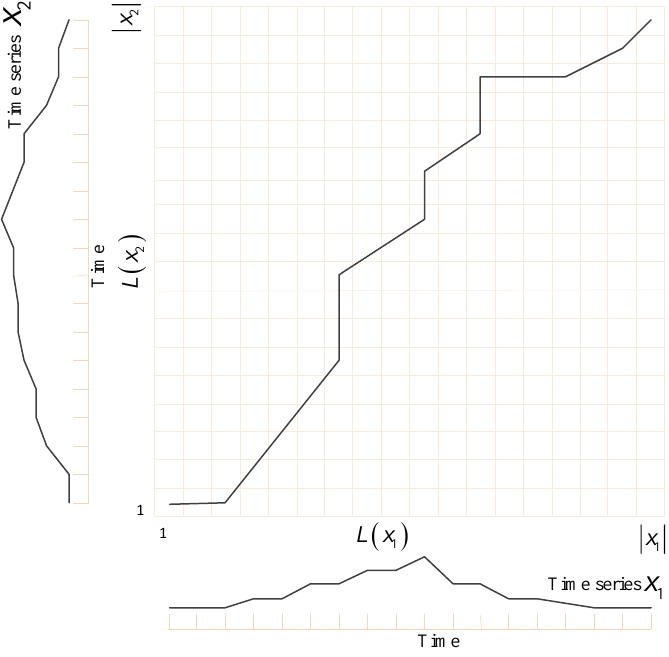
Figure 4. The cost matrix D { L ( x 1 ) , L ( x 2 ) } with minimum wrap path